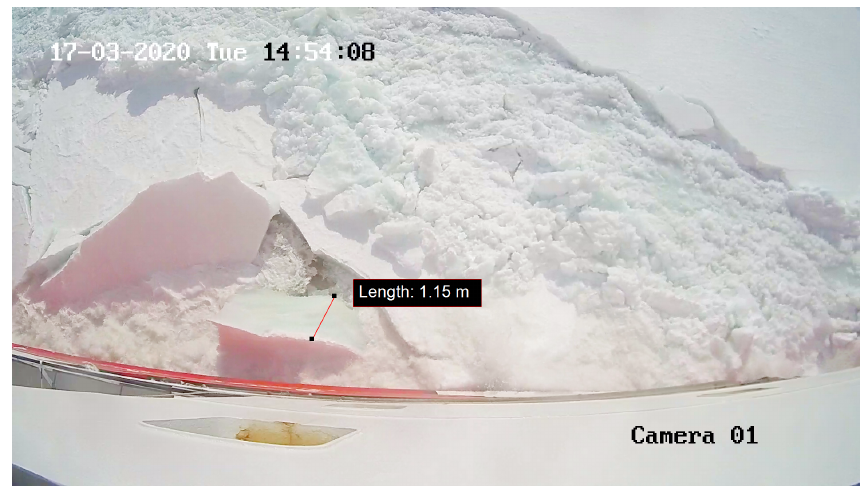
Figure 22. Ice conditions characterizing the time interval of the dataset from Figure 21. Figure 23 shows the data measured by the IMU XSens device in the time windows considered in the plots of Figures 19 and 21. Significant oscillations in both pitch and roll angles occur, along with several vertical acceleration peaks. In particular, at the end of the time window in Figure 23b, the pattern of a ramming motion can be observed: large vertical acceleration matching a rise in pitch angle while the bow hits the ice layer.